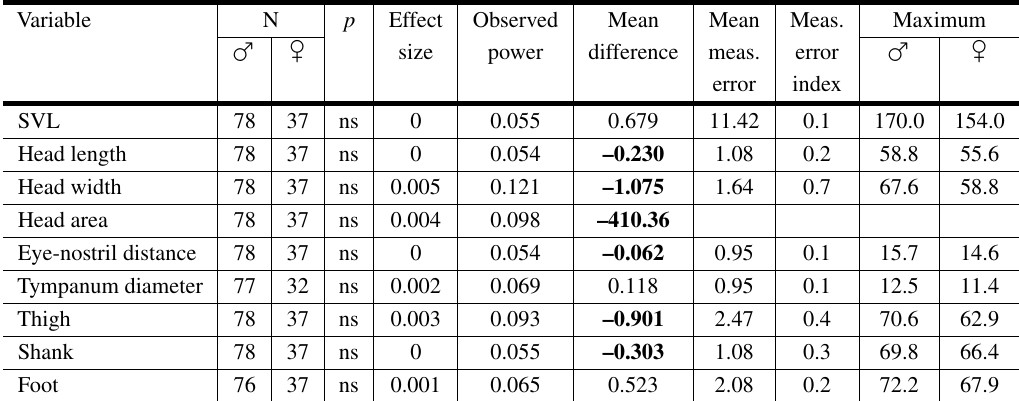
Sexual dimorphism statistics for Leptodactylus knudseni , Middle American pentadactylus, and L. pen- tadactylus measurement data. Meas. = measurement. Negative mean difference values (bold) indicate that male mean measurements are greater than female